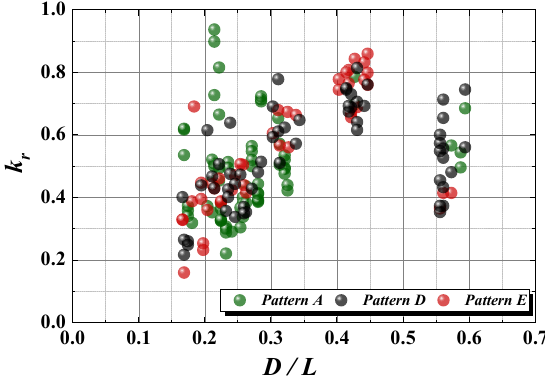
/ L and k r in patterns A, D, and